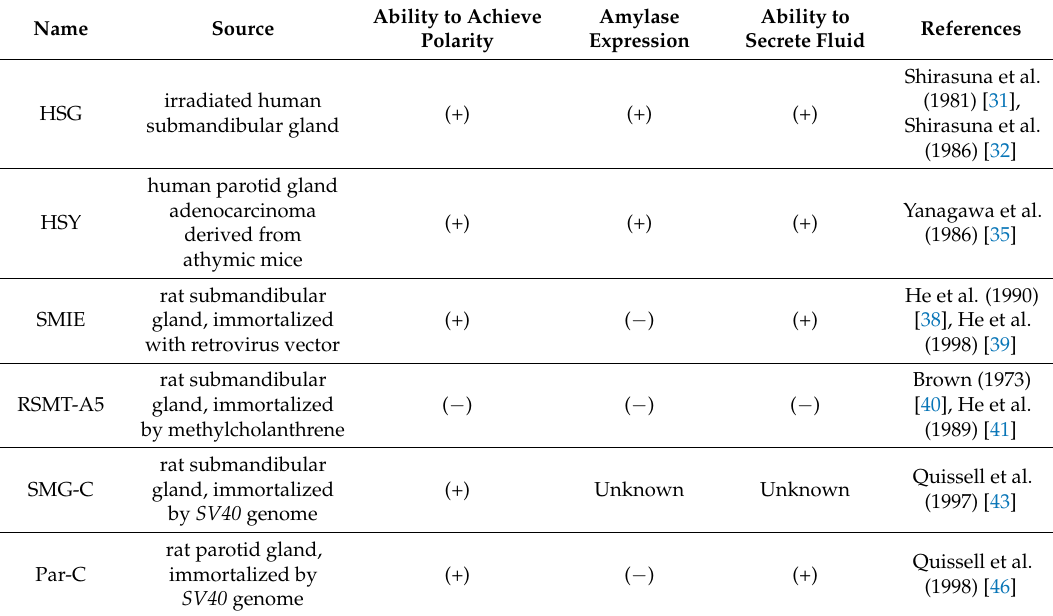
Table 2. Current cell models used to study the characteristics of salivary glands. Adapted from Nelson et al.